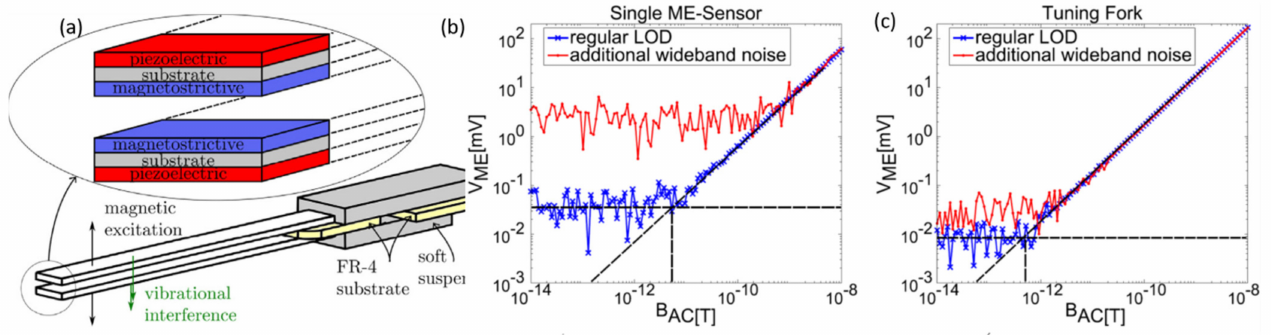
Figure 4. ( a ) Tuning fork structure consisting of two identical cantilever ME sensors placed on top and bottom of the mounting block. LOD plots of ( b ) a single ME sensor and ( c ) a tuning fork ME sensor with and without additional wideband noise. Reprinted with permission from ref. [30]. Copyright 2021 Elsevier